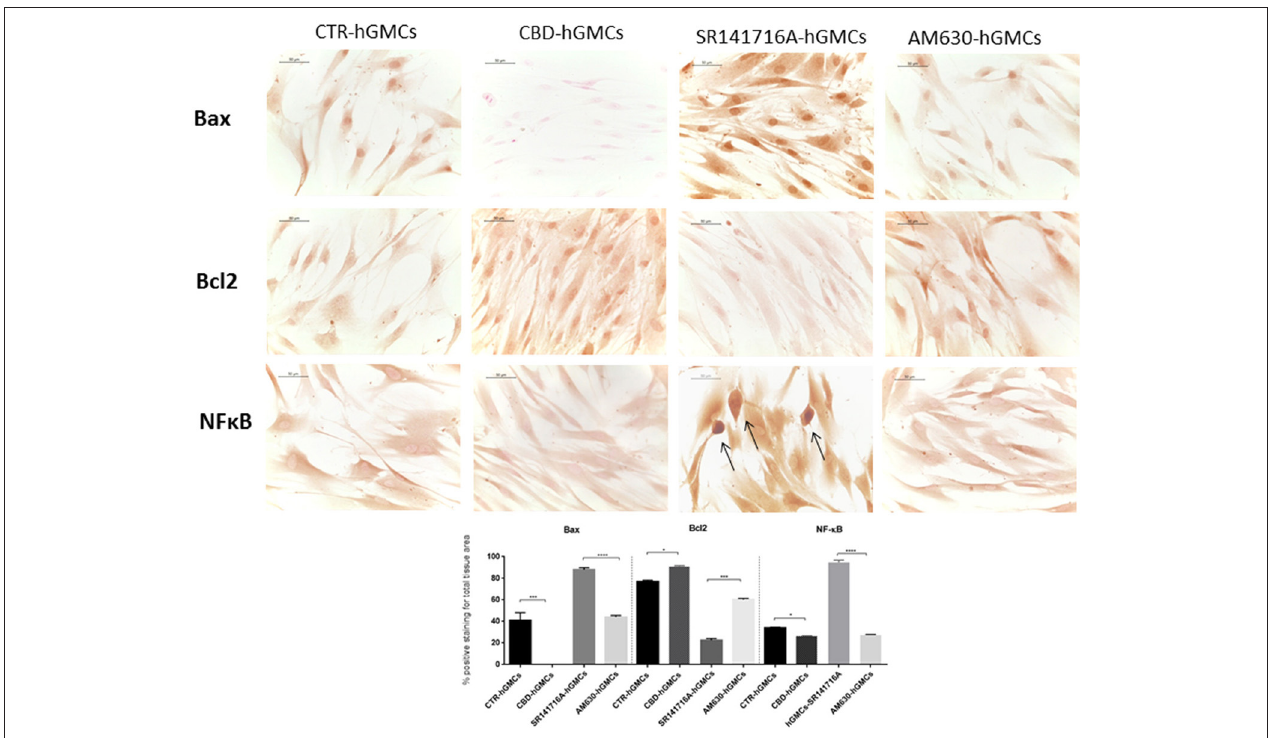
FIGURE 4 | Immunocytochemical staining for Bax, Bcl2 and NF κ B. CBD-hGMSCs showed a negative staining for Bax, a reduced expression for NF-KB and a positive staining for Bcl2, compared to CTR-hGMSCs. hGMSCs-SR141716A showed a marked positive cytoplasmatic/nuclear staining for NF-kB, as indicated by the arrows. Moreover, hGMSCs-SR141716A showed an increased nuclear expression for Bax and reduced expression for Bcl2 at both cytoplasmatic and nuclear compartment, compared to CBD-hGMSCs. Instead, hGMSCs-AM630 showed a reduced expression for Bax and Bcl2 compared to CBD-hGMSCs. Whereas, no differences statistically differences were found for the NF-kB expression between CBD-hGMSCs and hGMSCs-AM630. The graph represented the densytometric quantitative analysis. For Bax CTR-hGMSCs vs. CBD-hGMSCs *** p < 0.001; SR141716A-hGMSCs vs. AM630-hGMSCs **** p < 0.0001. For Bcl2 CTR-hGMSCs